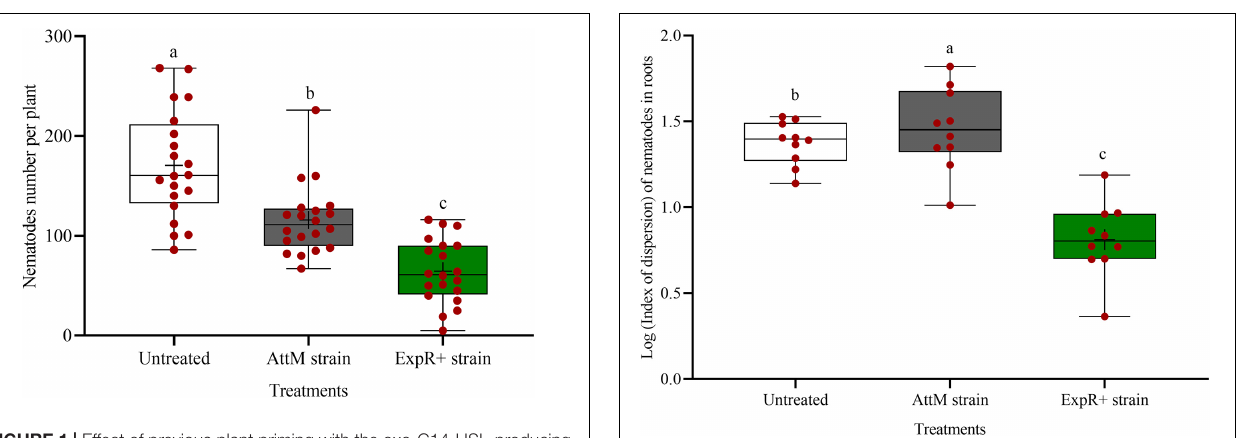
FIGURE 1 | Effect of previous plant priming with the oxo-C14-HSL-producing Ensifer meliloti ExpR + strain on the invasion of Pratylenchus penetrans into soybean roots. The lactonase-expressing strain E. meliloti AttM and MgCl 2 were used as controls without oxo-C14-HSL priming. Invaded nematodes were stained and counted 10 days post-infection. Different letters indicate significant differences among treatments (GLM, Poisson distribution and log link, Tukey adjustment, n = 20).